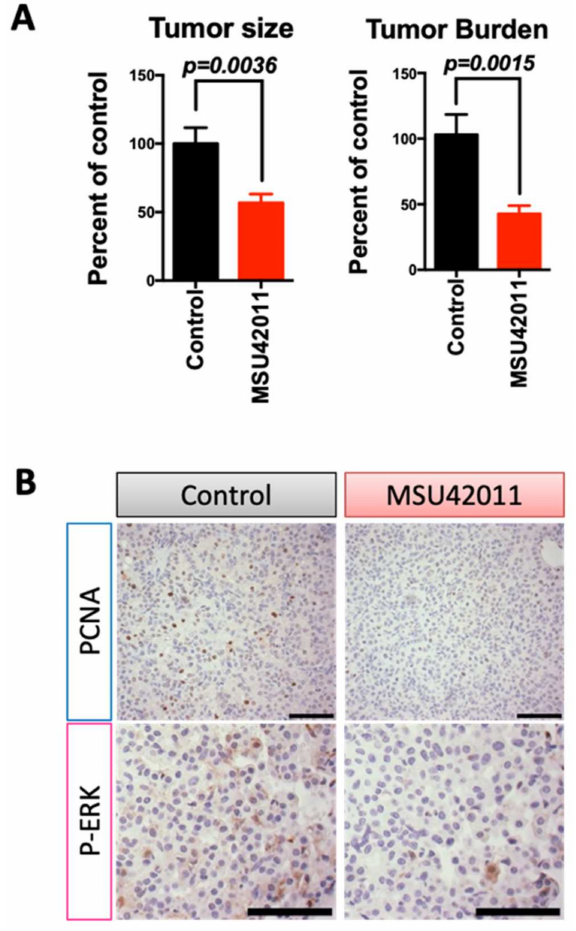
Figure 3. MSU42011 decreases tumor size and burden in AJ mice, a model of lung adenocarcinoma. Female A/J mice were injected with 2 doses of vinyl carbamate, 1 week apart, to initiate lung carcinogenesis. After 8 weeks, mice were fed either control AIN-93G diet or MSU42011 in the same diet (100 mg/kg diet). ( A ) Mice were euthanized 12 weeks after starting diet, and tumor size and burden were evaluated on lung sections ( n = 14–15/group). ( B ) Cell proliferation in the lung tumors was evaluated by immunostaining for PCNA (proliferating cell nuclear antigen). (scale bar 30 µ m). Table 1. The RXR agonist MSU42011 decreases tumor size and burden in a carcinogen-induced A/J model of lung